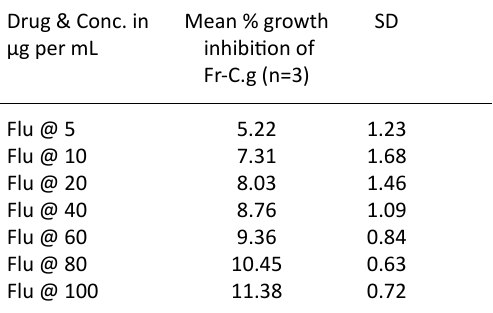
Table 4. Fluconazole resistant Candida glabrata Drug & Conc. in